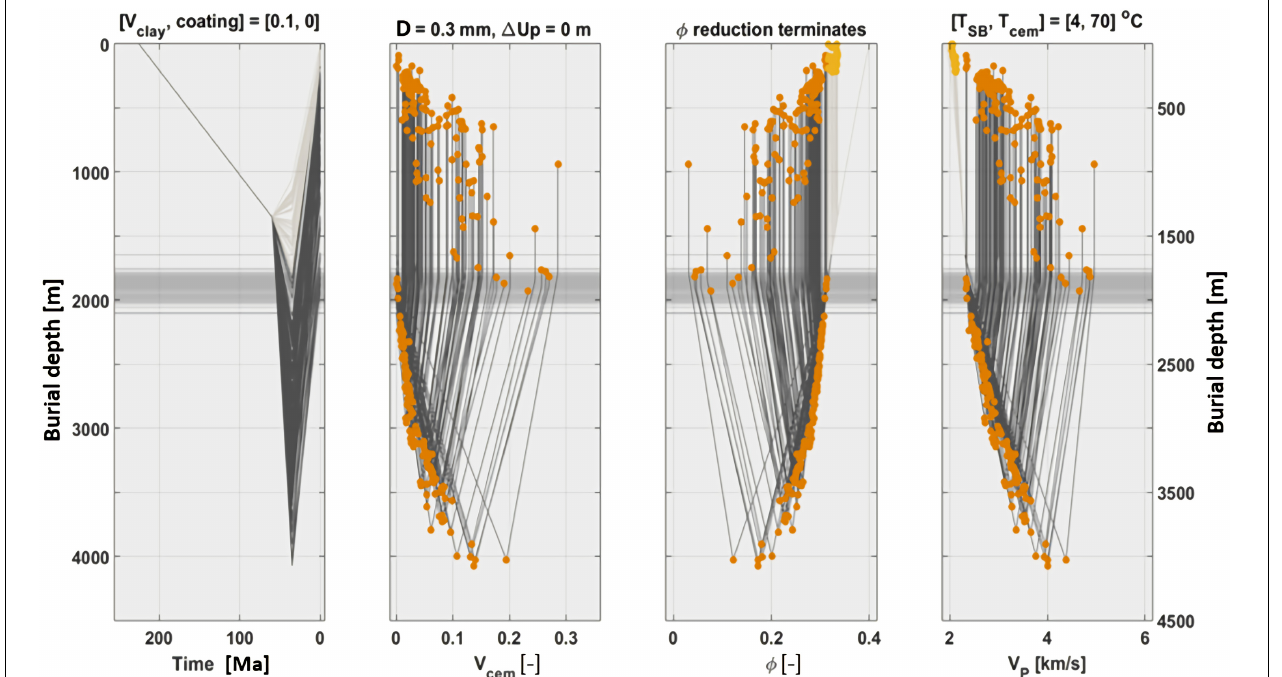
FIGURE 7 | Combined burial and rock physics modeling for clean sandstone of a Jurassic sandstone with varying burial history at different locations of the map shown in Figure 6 . Walderhaug model predicts the cement volume (subplot 2) for a given burial/temperature history (subplot 1), and the porosities are updated accordingly (subplot 3). Eventually, the seismic velocities are predicted using rock physics models (subplot 4). Note that the lighter burial history curves seen in subplot 1 are those that do not enter the cementation window (i.e., the T = 70 o C lower limit), not even at the time of their maximum burial. The corresponding end-points in porosity and V P subplots are marked by lighter orange color to discern them from the (majority of darker) orange points that have been at least slightly cemented. Note also that since the T grad varies from point-to-point, the depth of cementation onset can change from one X–Y point to another: this transition from a mechanical compaction domain to a chemical compaction domain for each curve is seen as a horizontal (gray) line in each